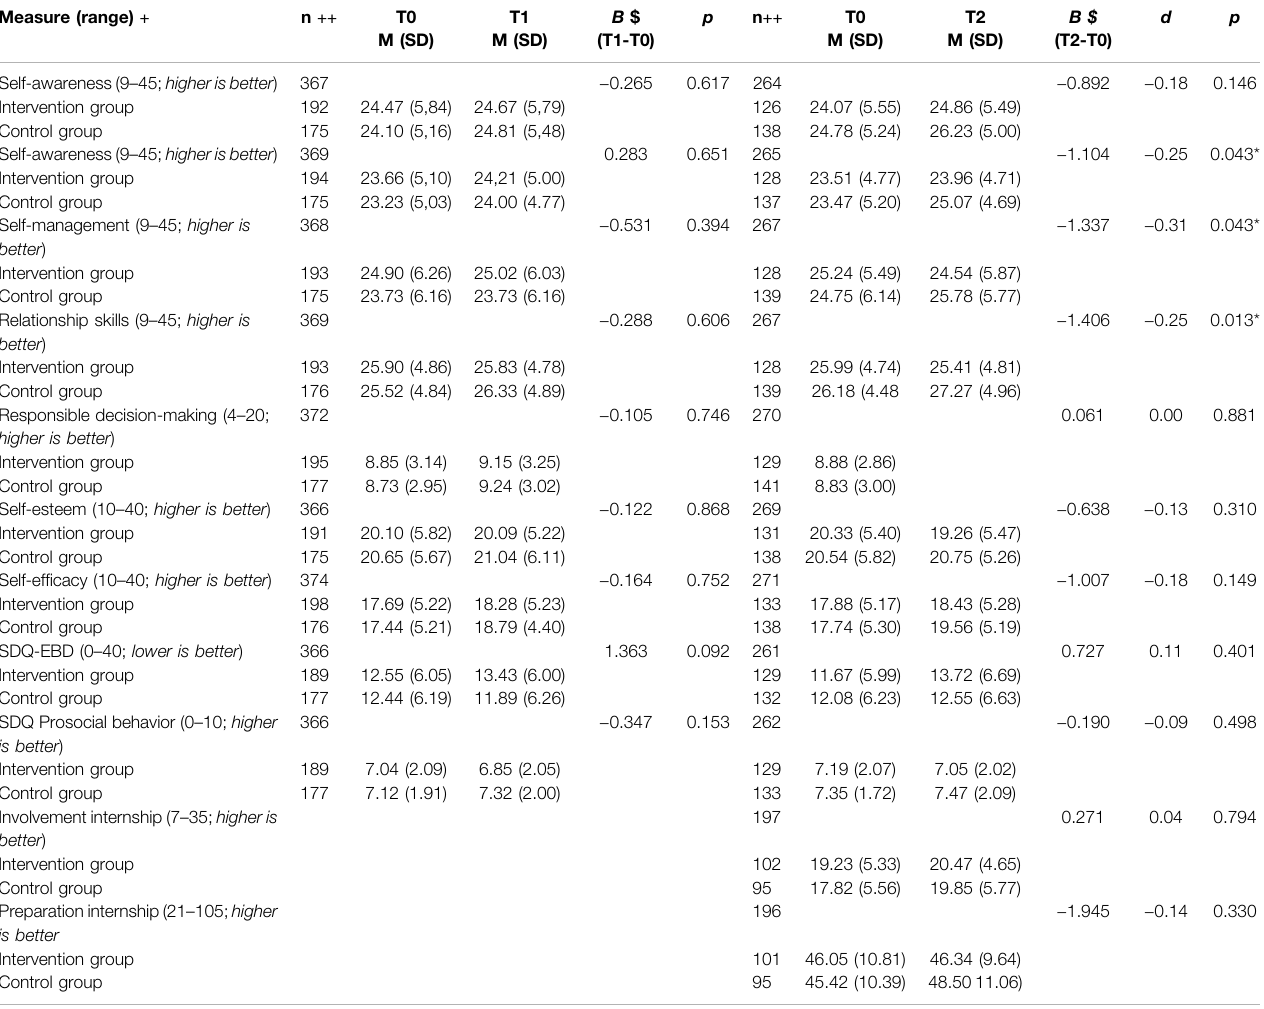
TABLE 3 | Means, Standard Deviations, and Multi-level Model Analyses SEL skills, Psychosocial, and Internship T1 – T0 Measure (range) + n ++ T0 M